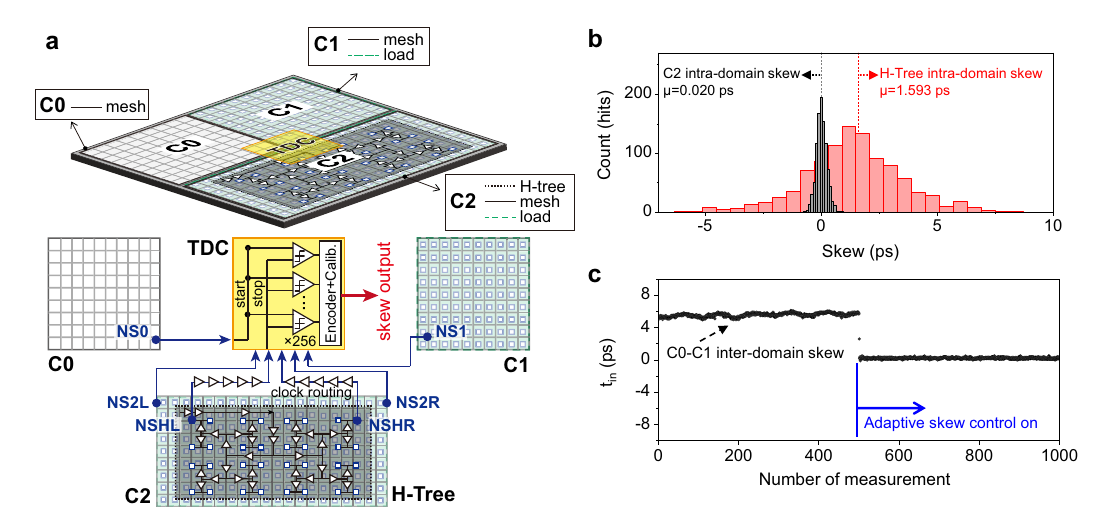
Fig. 4 | Photocurrent pulse jitter characterization. a Experimental setup to characterizethetimingjitterofphotocurrentpulsesatdifferenttemporalpositions usingtheEOS-TD 29 . b (i)Measuredphotocurrentpulsewaveformand(ii)integrated